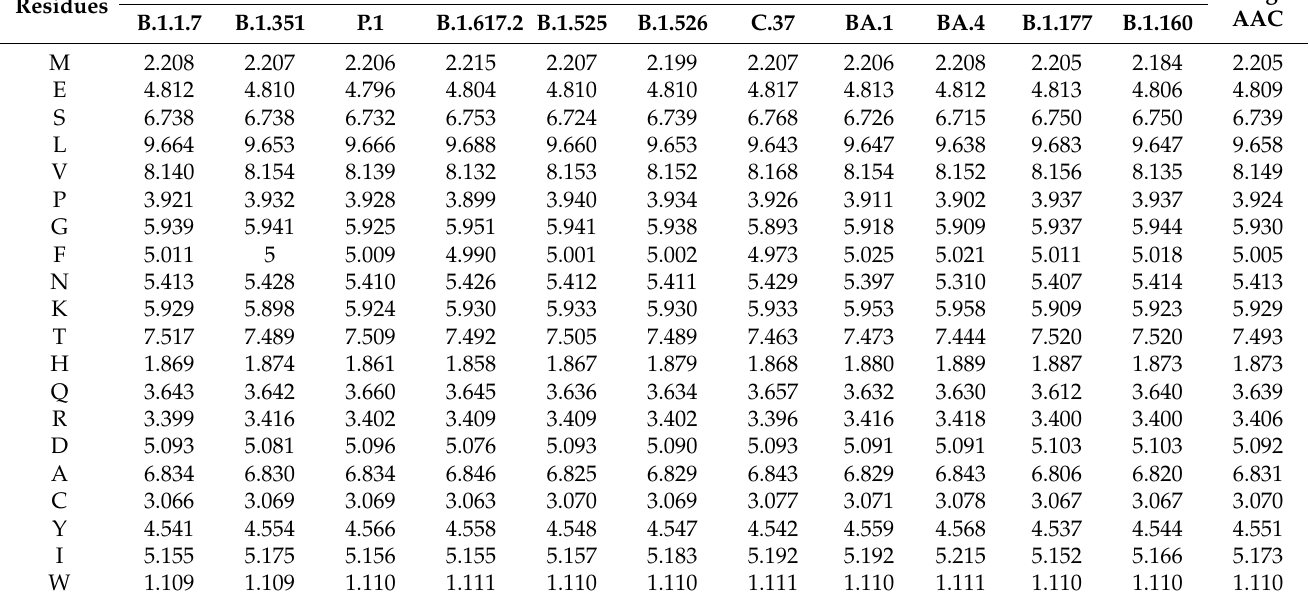
Table 3. Average amino acid composition for each SARS-CoV-2 variant. Values are presented up to 3 decimal